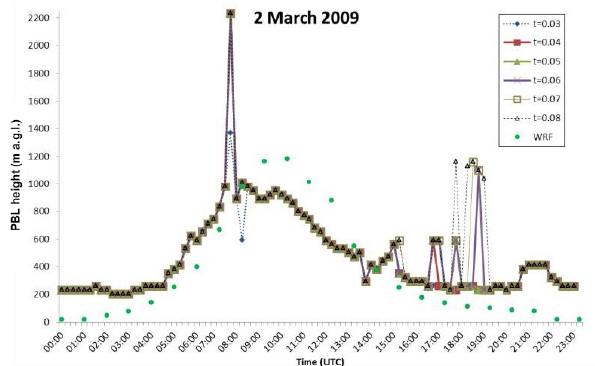
Figure A1. Sensitivity analysis of the WCT method for the case of 2 March 2009. PBLH was estimated by FMI–Polly XT after modifi- cation of the WCT threshold, and by the WRF